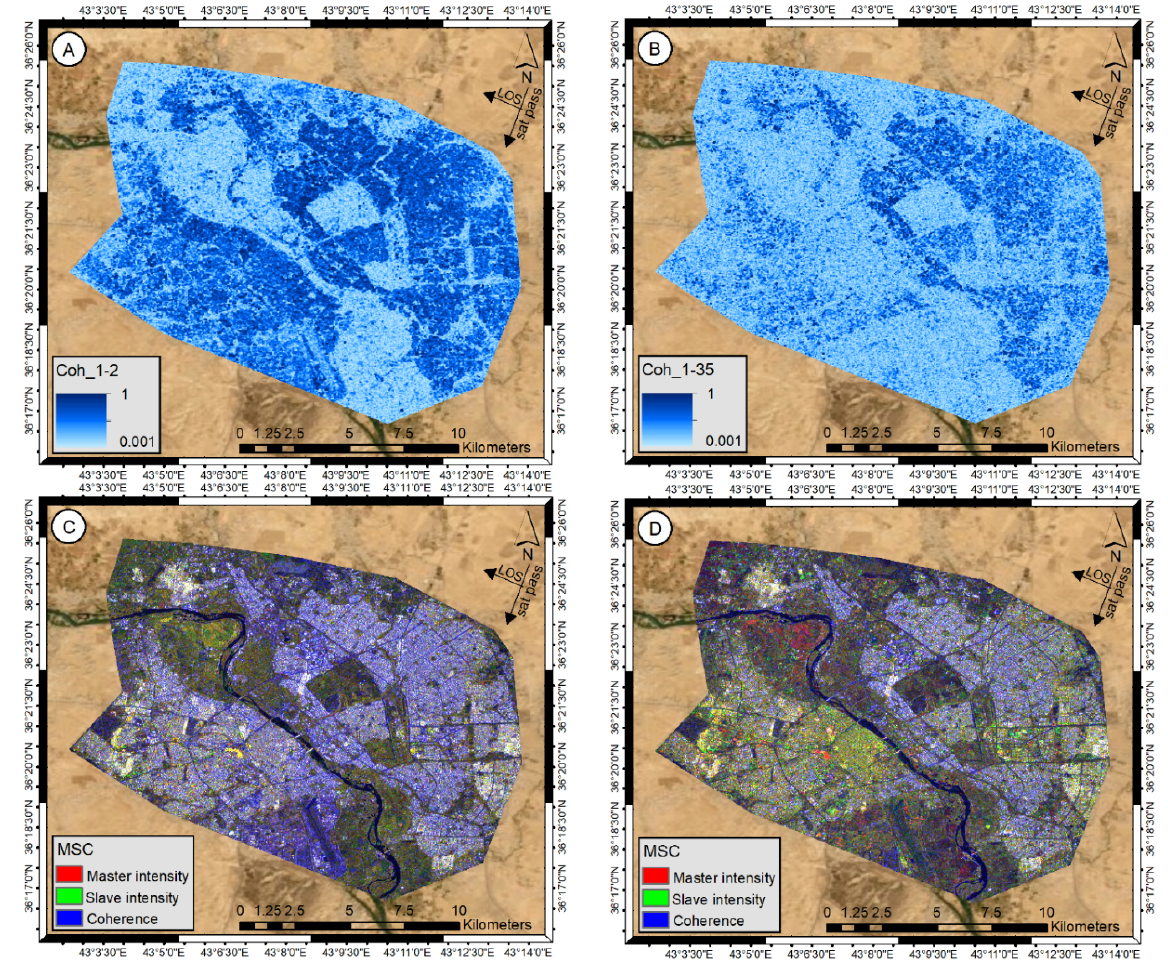
Figure 6. Coherence and intensity maps. ( A ) the coherence map estimated using the first and second S1 data (pre-war period), ( B ) the coherence map estimated using the first and last (35th) S1 data (post-war period), ( C ) RGB color composite of Master–Agent intensity and Coherency (MAC) obtained by using the first and second S1 data (pre-war period) and ( D ) MAC estimated using the first and last (35th) S1 data (post-war